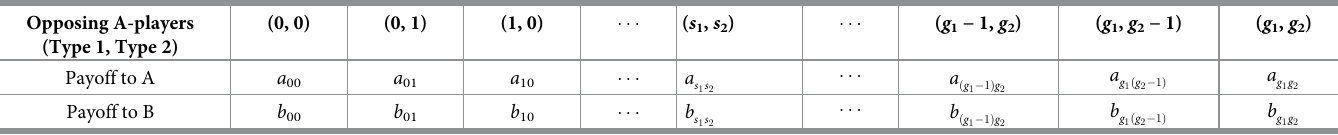
Within an neighborhood of ( s 1 , s 2 ), a focal A-player derives payoff a